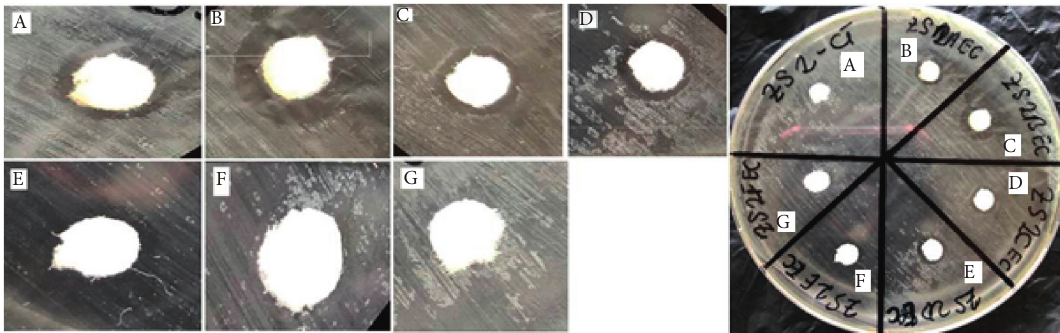
Figure 14: Antibacterial activity of ZnO/Ag nanocomposite against E . coli . The paper disks were impregnated with the following suspension of copper oxide nanoparticles: A � 5mg/ml, B � 2 mg/ml, C � 1mg/ml, D � 0.5mg/ml, E � 0.25mg/ml, F � 0.1mg/ml, and G � 0 mg/ml.